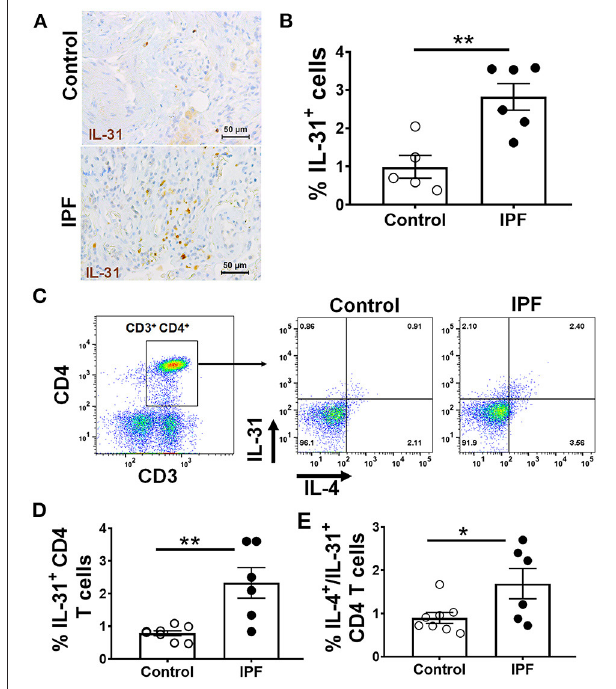
FIGURE 5 | Increased staining and frequency of IL-31-positive CD4T cells in IPF. Lung sections from IPF and non-IPF control subjects were probed to detect the expression of IL-31 by immunohistochemistry, (A) Representative images of IL-31 expression in non-IPF (top) and IPF (bottom) lung sections. (B) Percent of IL-31 + cells in total lung cells quantified in IHC stained lung sections. Data are shown as mean ± SEM., ** p < 0.01. Peripheral blood mononuclear cells (PBMC) of IPF patients ( n = 7) and healthy control subjects ( n = 8) were isolated and stimulated with PMA and ionomycin, intracellular cytokine expression of IL-31 and IL-4 were assessed by flow cytometry. (C) Representative images of CD3 CD4 cells expressing IL-31 and IL-4. (D) Percent of IL-31 and (E) IL4/IL-31- producing CD4T cells are shown. Data presented as mean ± SEM with n = 6-9, with * p < 0.05, ** p < 0.01. Student t -test was used to compare the mean between